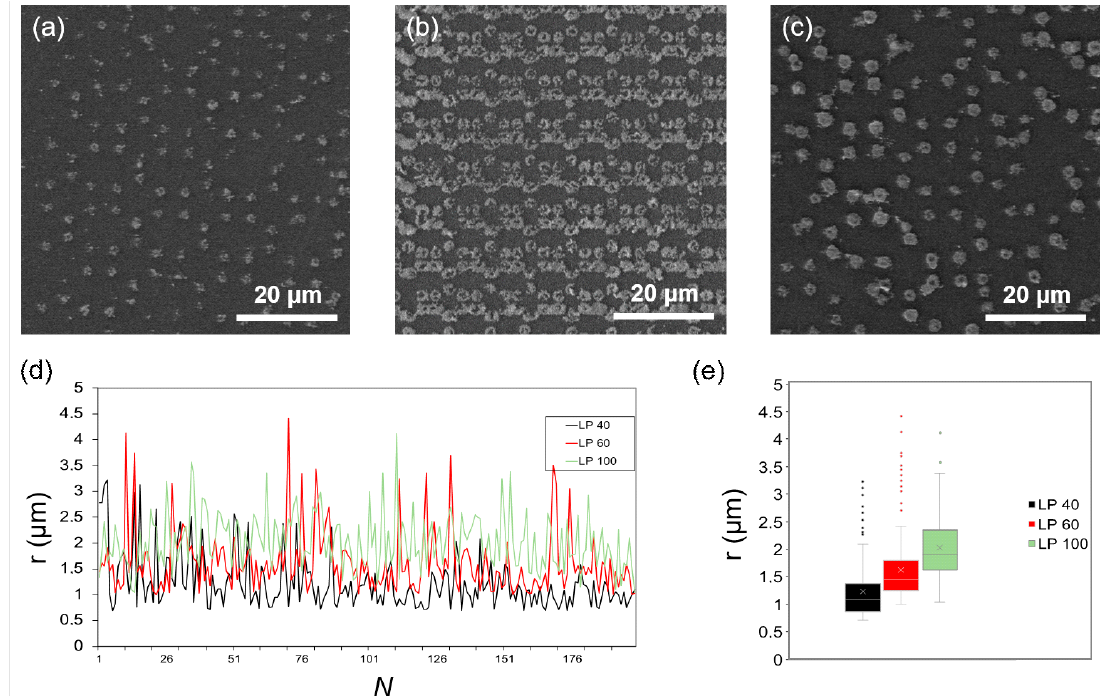
Figure 2. SEM micrographs showing AuNSs fabricated via TPA–DLW using an ET = 100 ms and an LP of ( a ) 40 mW; ( b ) 60 mW; ( c ) 100 mW. ( d ) Quantification and ( e ) box plot of the radius of the different AuNSs printed. Box plots were made in all cases from at least 180 independent measurements ( N > 180), as shown in ( d ).